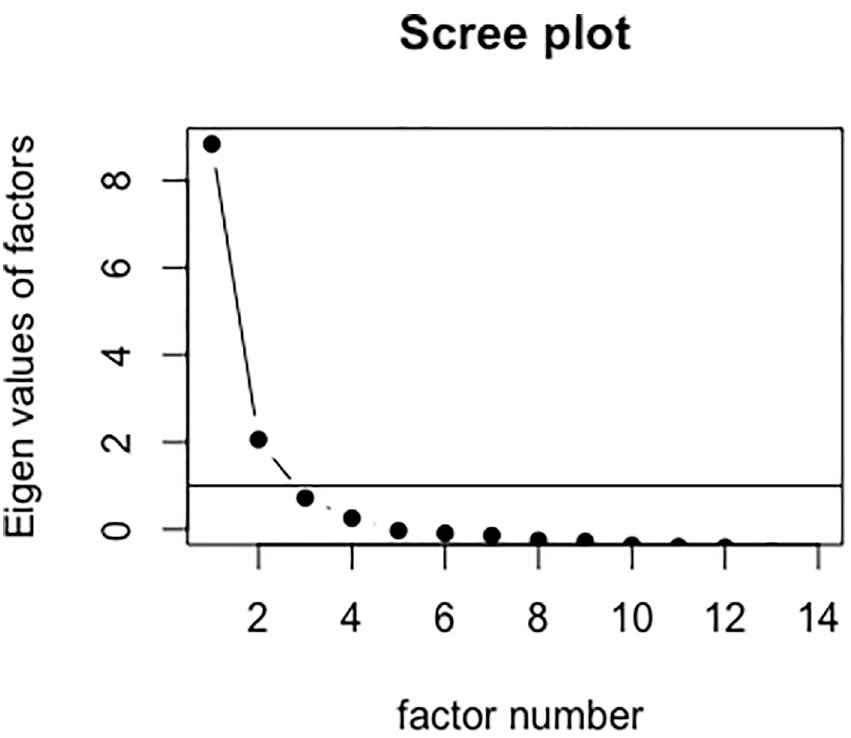
Fig 2. Scree plot of alpha diversity indices. Scree plot showing likely number of factors underlying the relationships among alpha diversity indices.